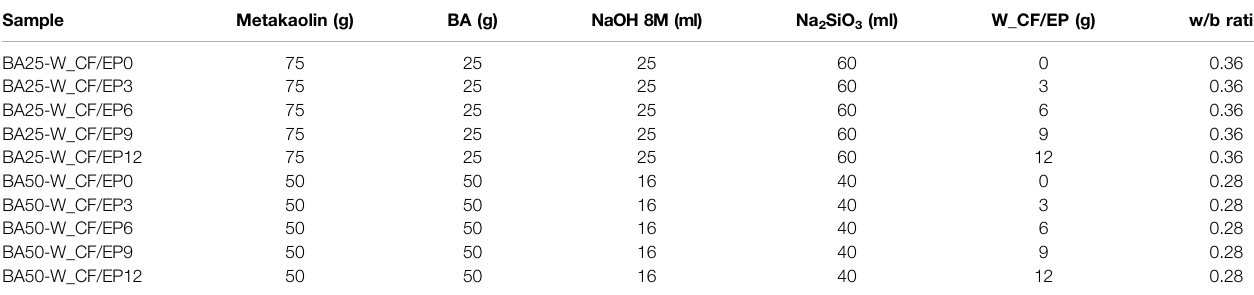
TABLE 2 | Formulation of composites.